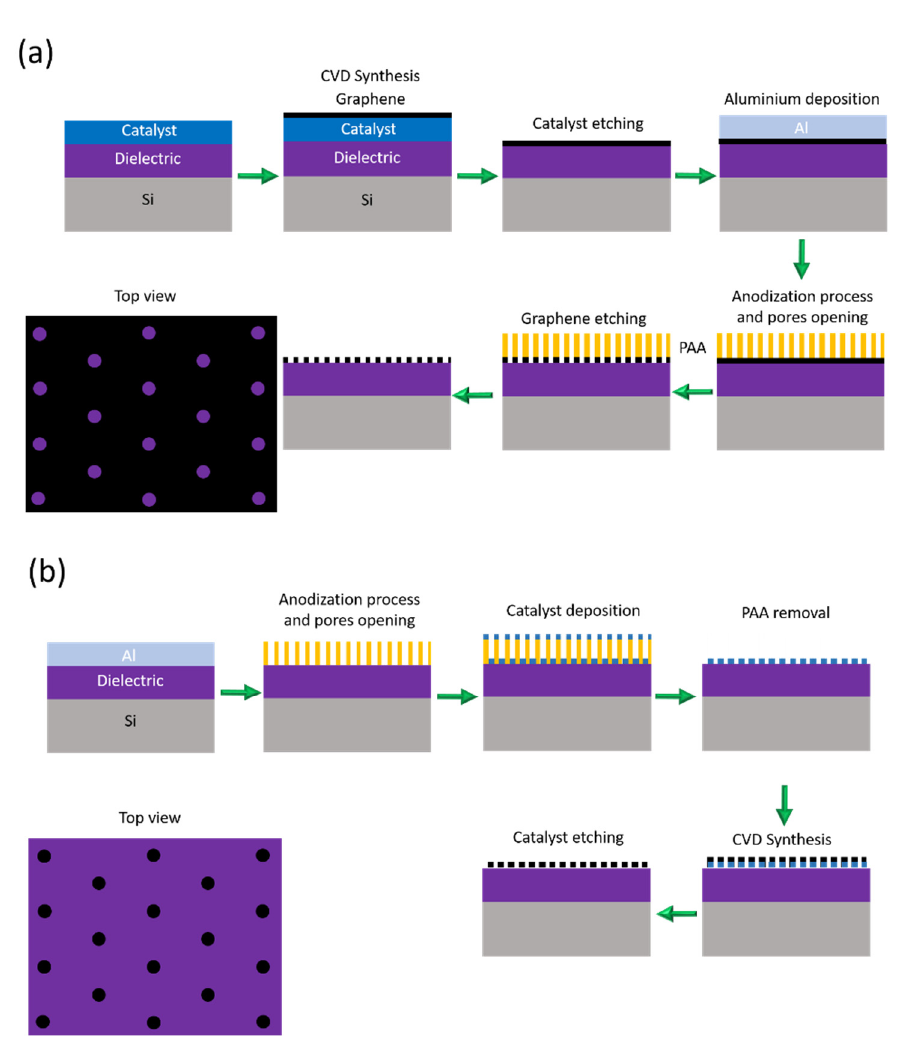
Figure 21. Schematic representation of workflow proposed to fabricate a PAA/graphene assembly with a transfer-free process. ( a ) The workflow to obtain a positive pattern of graphene on a substrate. ( b ) The workflow to obtain a negative pattern of graphene on a substrate.